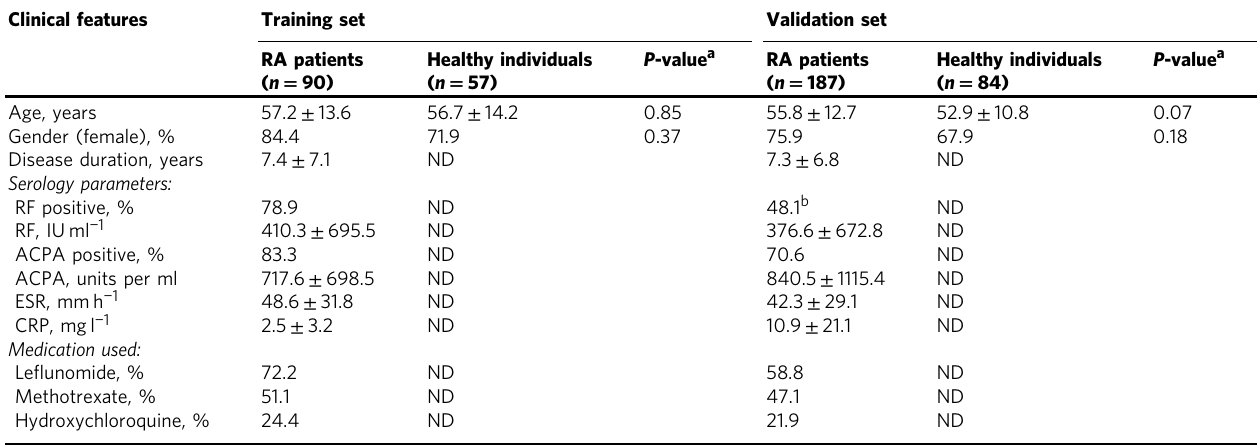
Table 3 Clinical features of RA patients and healthy individuals Clinical